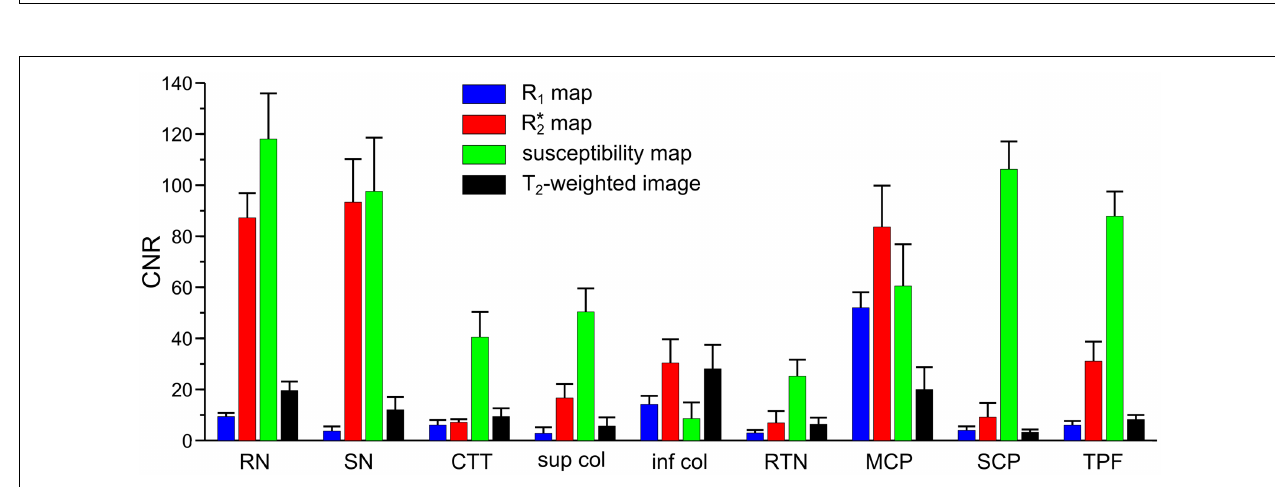
surrounding tissue (without red nucleus), sup col - superior colliculus vs. FIGURE 2 | Contrast-to-noise ratio (CNR) of selected anatomical regions . Mean values of CNR across six subjects and both hemispheres were adjacent tissue, inf col - inferior colliculus vs. adjacent tissue, RTN - extracted from R 1 (blue bars), R ∗ (red bars), and susceptibility maps (green reticulotegmental nucleus vs. surrounding white matter tissue, MCP - middle 2 bars) as well as T 2 -weighted images (black bars). Brain regions include: RN - cerebellar peduncle vs. adjacent cerebrospinal fluid, SCP - superior cerebellar red nucleus vs. surrounding tissue, SN - substantia nigra vs. tissue between peduncle vs. reticular formation,TPF - transverse pontine fibers vs. red nucleus and substantia nigra, CTT - central tegmental tract vs. corticospinal tract.The error bars indicate the 95%-confidence